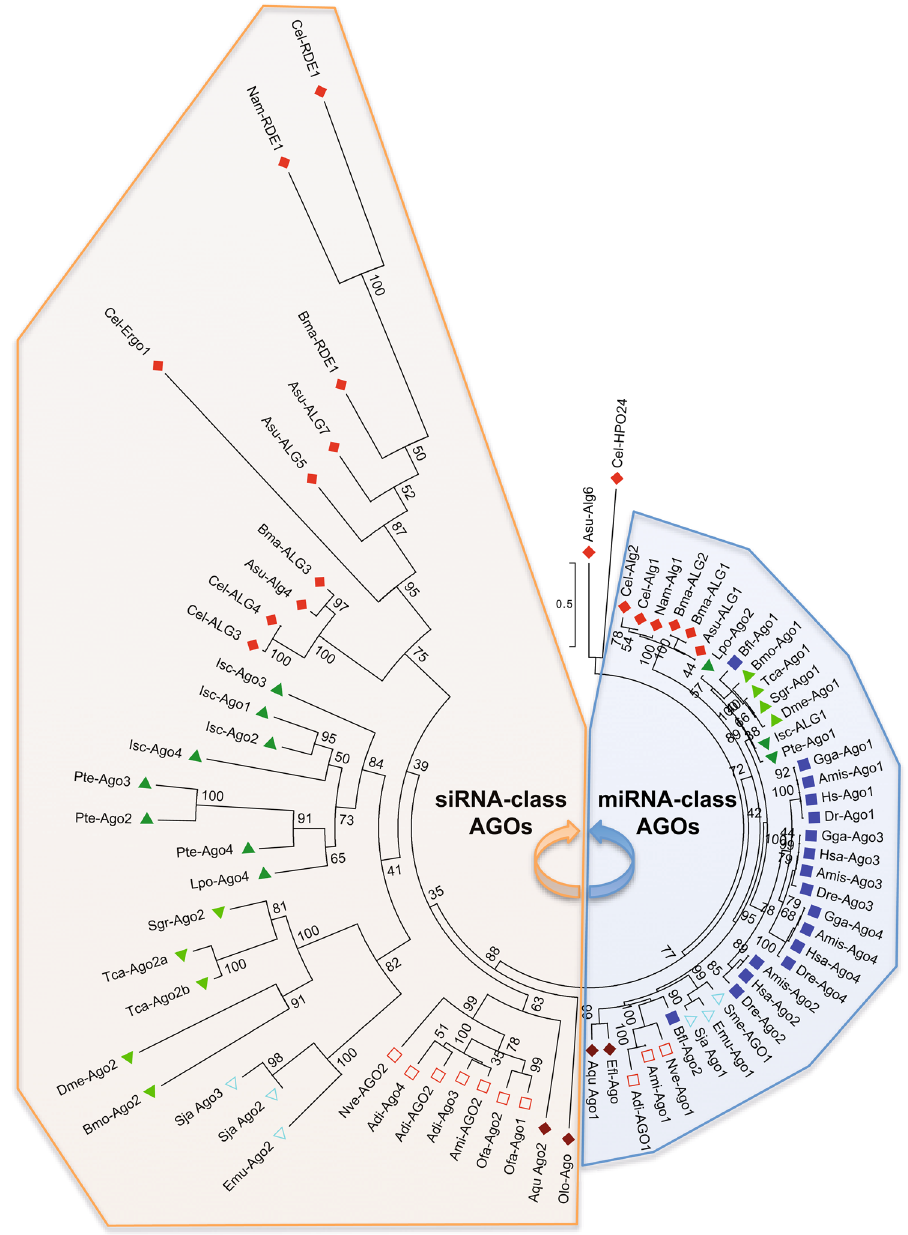
Figure 2. Unrooted maximum likelihood phylogenetic tree (100 bootstraps) using the AGO Argonaute members belonging to Porifera ( : Amphimedon queenslandica ; Aqu, Ephydatia fluviatillis ; Efl, Oscarella lobularis ; Olo), Cnidaria ( : Acropora digitifera ; Adi, Acropora millepora ; Ami; Orbicella faveolata ; Ofa, Nemastella vectensis ; Nve), Chordata ( : Homo sapiens ; Hsa, Alligator mississippiensis , Ami; Gallus gallus ; Gga; Danio rerio ; Dre, Brachiostoma floridae ; Bfl), Nematoda ( : Caenorhabditis elegans ; Cel, Ascaris suum ; Asu, Brugia malayi ; Bma, Necator americanus ; Nam), Arthropoda (Insecta: : Drosophila melanogaster ; Dme, Bombyx mori ; Bmo, Tribolium castaneum ; Tca, Schistocerca gregaria , Sgr; and Chelicerata: : Ixodes scapularis ; Isc, Parasteatoda tepidariorum ; Pte, Limulus polyphemus ; Lpo) and Platyhelminthes ( : Echinococcus multilocularis ; Emu, Schistosoma japonicum ; Sja, Schmistea mediterranea ; Sme). Detailed information on the sequences used is presented in Suppl. Table S2. The AGO Argonaute family can be dissected into two distinct groups: (I) miRNA-class AGOs and (II) siRNA-class